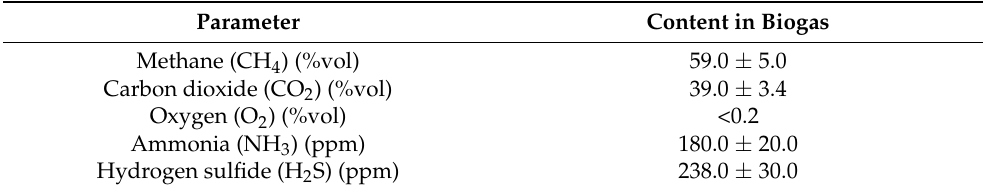
Table 2. The composition of